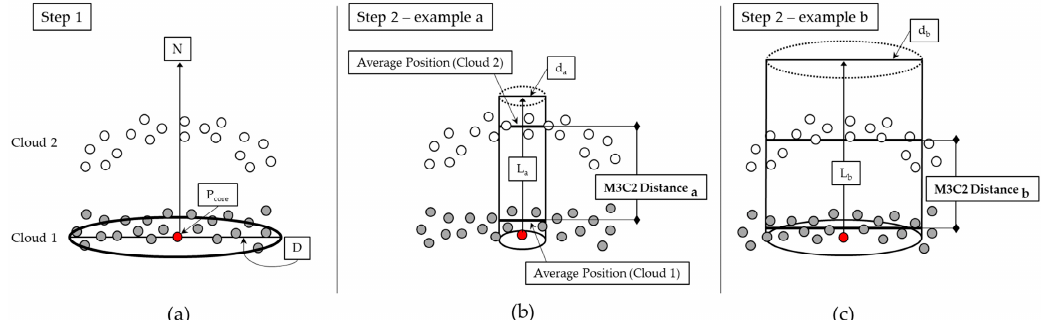
Figure 1. A depiction of the steps involved in multiscale model-to-model cloud comparison (M3C2) distance computation. ( a ) In Step 1, the local normal vector, N, is estimated from Cloud 1 by fitting a plane to the points within a radius of D/2 from P core ; ( b ) In Step 2, a cylinder is projected from P core along the normal vector. The average position is computed for each cloud, along the normal vector, using the points encompassed within the search cylinder. The difference in the average positions is the M3C2 distance. The projection diameter d a and the maximum search length L a are defined by the user; ( c ) Step 2 is shown with a larger projection diameter d b , resulting in more spatial averaging in the distance computation. A larger search length, L b , is also shown. Modified from Crawford et al. [47]. In reality, the search cylinder is projected in both directions, looking for Cloud